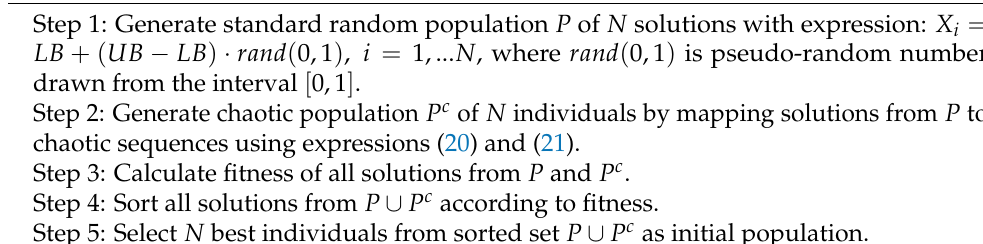
Algorithm 1 Pseudo-code for chaotic-based population